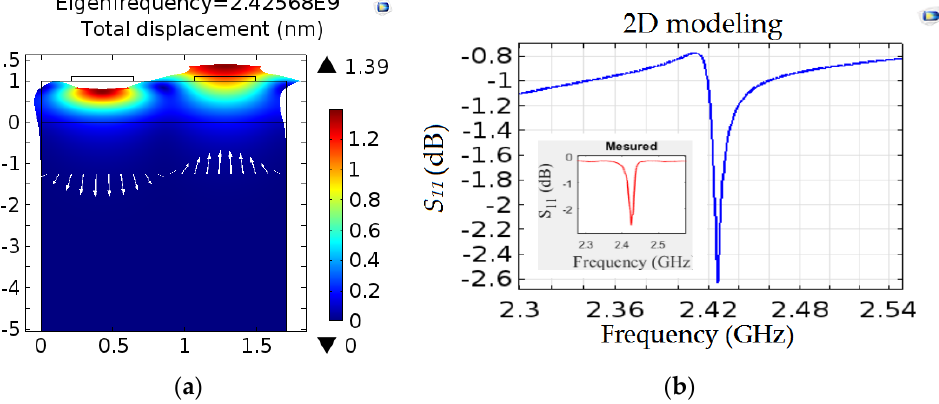
Figure 2. ( a ) Total mechanical displacement amplitude, ( b ) S 11 parameters of the Pt/AlN/Sapphire device, modeled and measured.